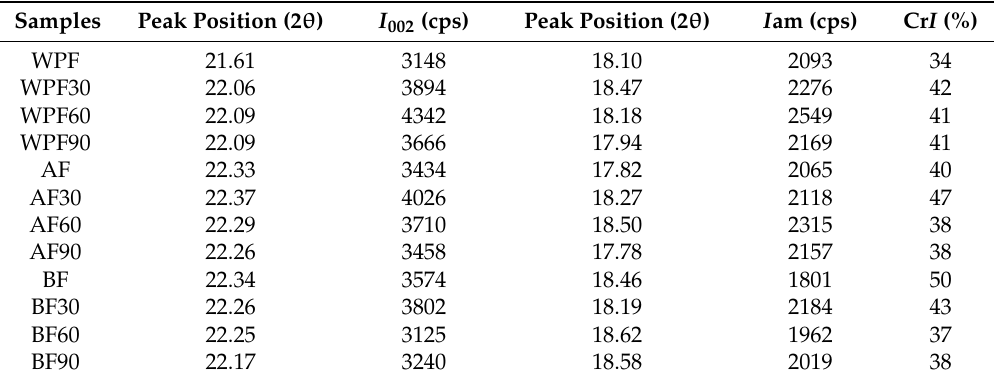
Table 1. Crystallinity of windmill palm fiber, before and after degradation.